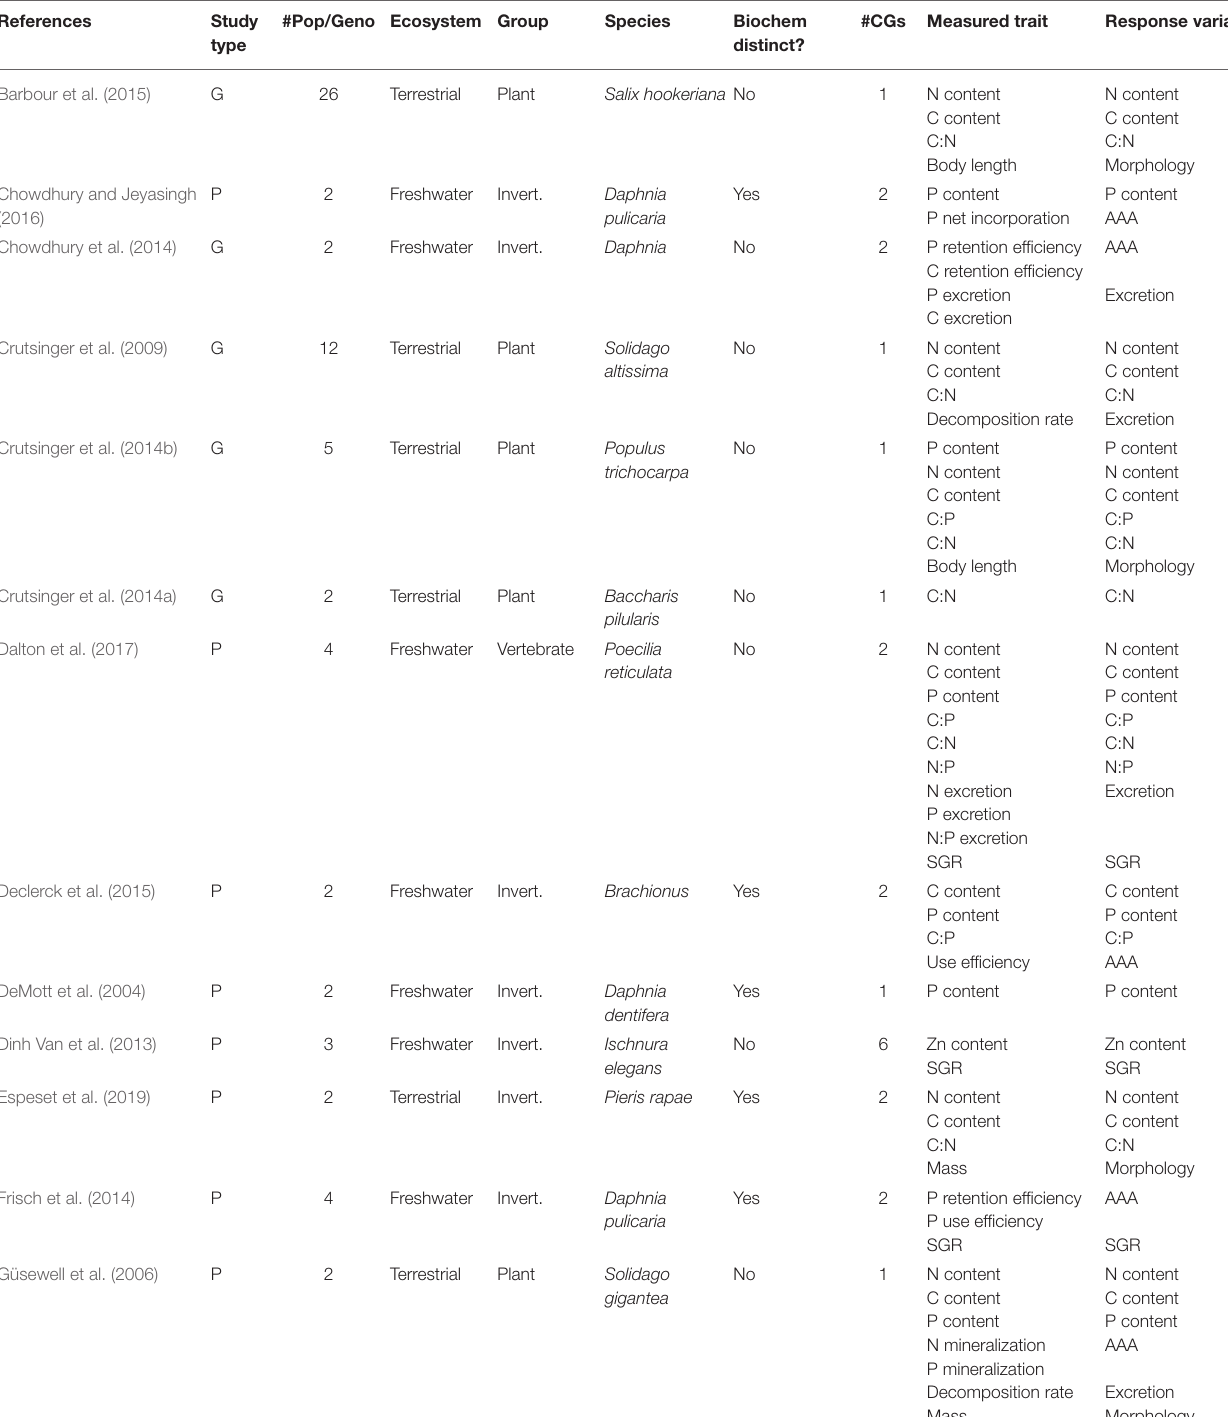
TABLE 1 | A complete list of the studies included in the meta-analysis, with information on study type—either populations (“P”) or genotypes (“G”); the number of populations/genotypes (“# Pop/Geno”), the type of ecosystem considered (Terrestrial, Freshwater or Marine); the coarse taxonomic group of the study organism (Plant, Invertebrate, or Vertebrate); the Latin name of the study organism; for populations, if they were from biogeochemically distinct environments (always “no” for genotypes); the number of common gardens in the experimental setup (“# CGs”); the list of traits that were measured in the study (“Measured Trait”), and; the trait category under which they were grouped in the meta-analysis (“Response Variable,” with “SGR” standing for Somatic Growth